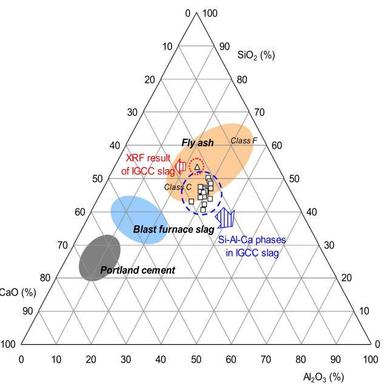
SiO2-Al2O3-CaO ternary phase diagram of Si-Al-Ca phases in typical Portland cement, blast furnace slag, and fly ash. The chemical composition of the phase in the IGCC slag is more similar to that in Class C fly ash than other byproducts presented in the phase diagram.